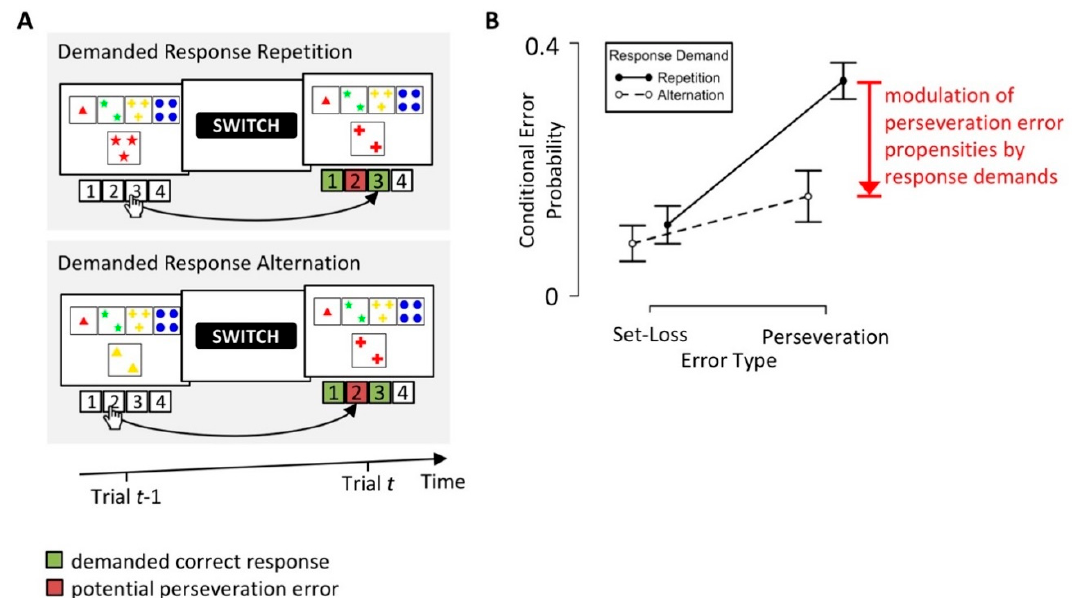
Figure 3. A modulation of PE propensities by response demands. ( A ) In a recent behavioral study [26], we stratified PE by response demands. With a demanded response repetition, the commitment of a PE (i.e., the re-application of the number category by executing response 2 on Trial t ) implies an alternation of the previously executed response (i.e., response 3 on Trial t − 1). With a demanded response alternation, the commitment of a PE (i.e., the re-application of the number category by executing response 2 on Trial t ) implies the repetition of the previously executed response (i.e., response 2 on Trial t − 1). ( B ) We found a modulation of PE propensities by response demands [26]. Participants showed reduced PE propensities on trials with a demanded response alternation when compared to trials with a demanded response repetition. Please note that we did not find evidence for a modulation of set-loss error (SLE) propensities by response demands.